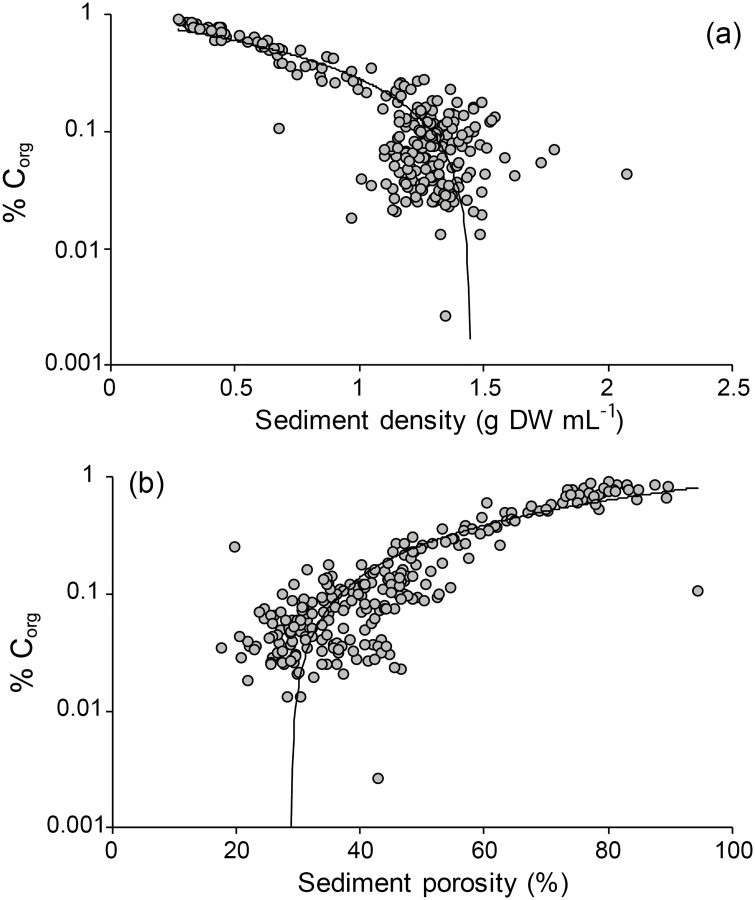
Semi-log plots (log10[x+1]) for sediment density (a) and sediment porosity (b) in relation to % Corg for the Z. marina sites.The sediment density (g DW mL-1) was negatively influencing the amount of organic carbon (R2 = 0.84, P < 0.001), while there was a positive relation between sediment porosity (%) and % Corg (R2 = 0.80, P < 0.001).